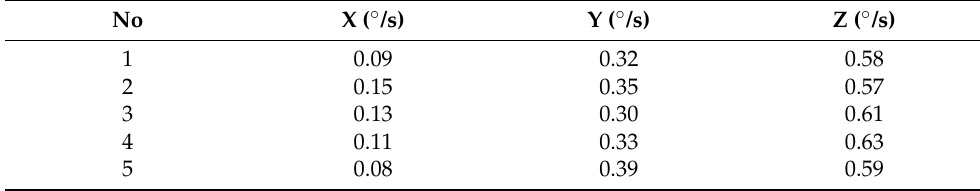
Table 10. Test value for the angular